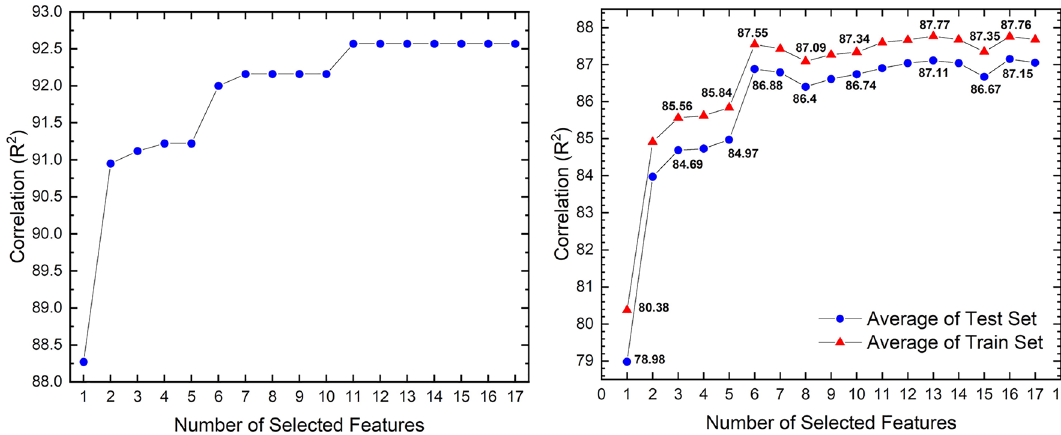
Figure 2. The squared correlation coefficient (R 2 ) of 5-fold cross-validated models based on the number of selected features for ( a ) test set of the most accurate models with the highest R 2 and ( b ) averages train sets and test sets of 100 repeated